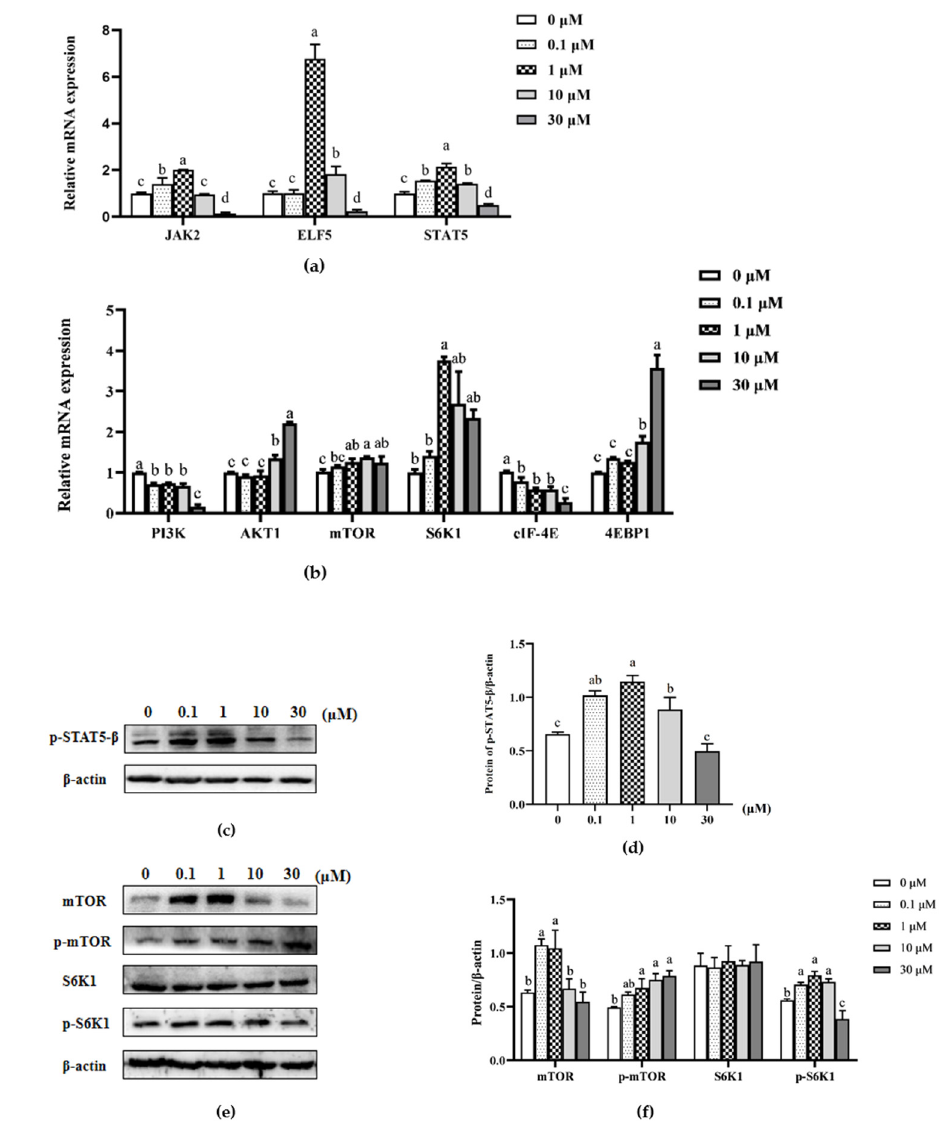
Figure 2. Effects of β -sitosterol on casein biosynthesis-related pathways in MAC-T cells. ( a ) mRNA expression of JAK2/STAT5 signaling pathway-related genes determined by qPCR. ( b ) mRNA ex- pression of mTOR signaling pathway-related genes determined by qPCR. ( c ) Levels of p-STAT5- β protein detected by Western blotting. ( d ) The ratio of p-STAT5- β protein to β -actin control. ( e ) Levels of mTOR, p-mTOR, S6K1, and p-S6K1 proteins detected by Western blotting. ( f ) The ratio of mTOR, p-mTOR, S6K1, and p-S6K1 proteins to β -actin control. Data are mean ± SEM ( n = 3). Different lower- case letters indicate significant differences compared to the control ( p < 0.05).